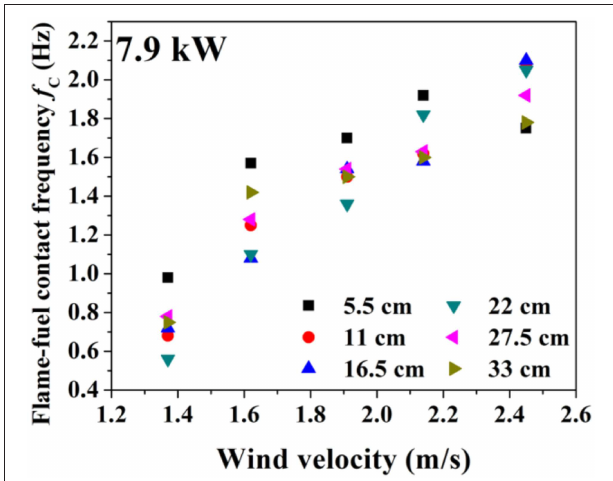
FIGURE 6 | Local flame fuel contact frequency for a 7.9 kW fire under different wind velocities.